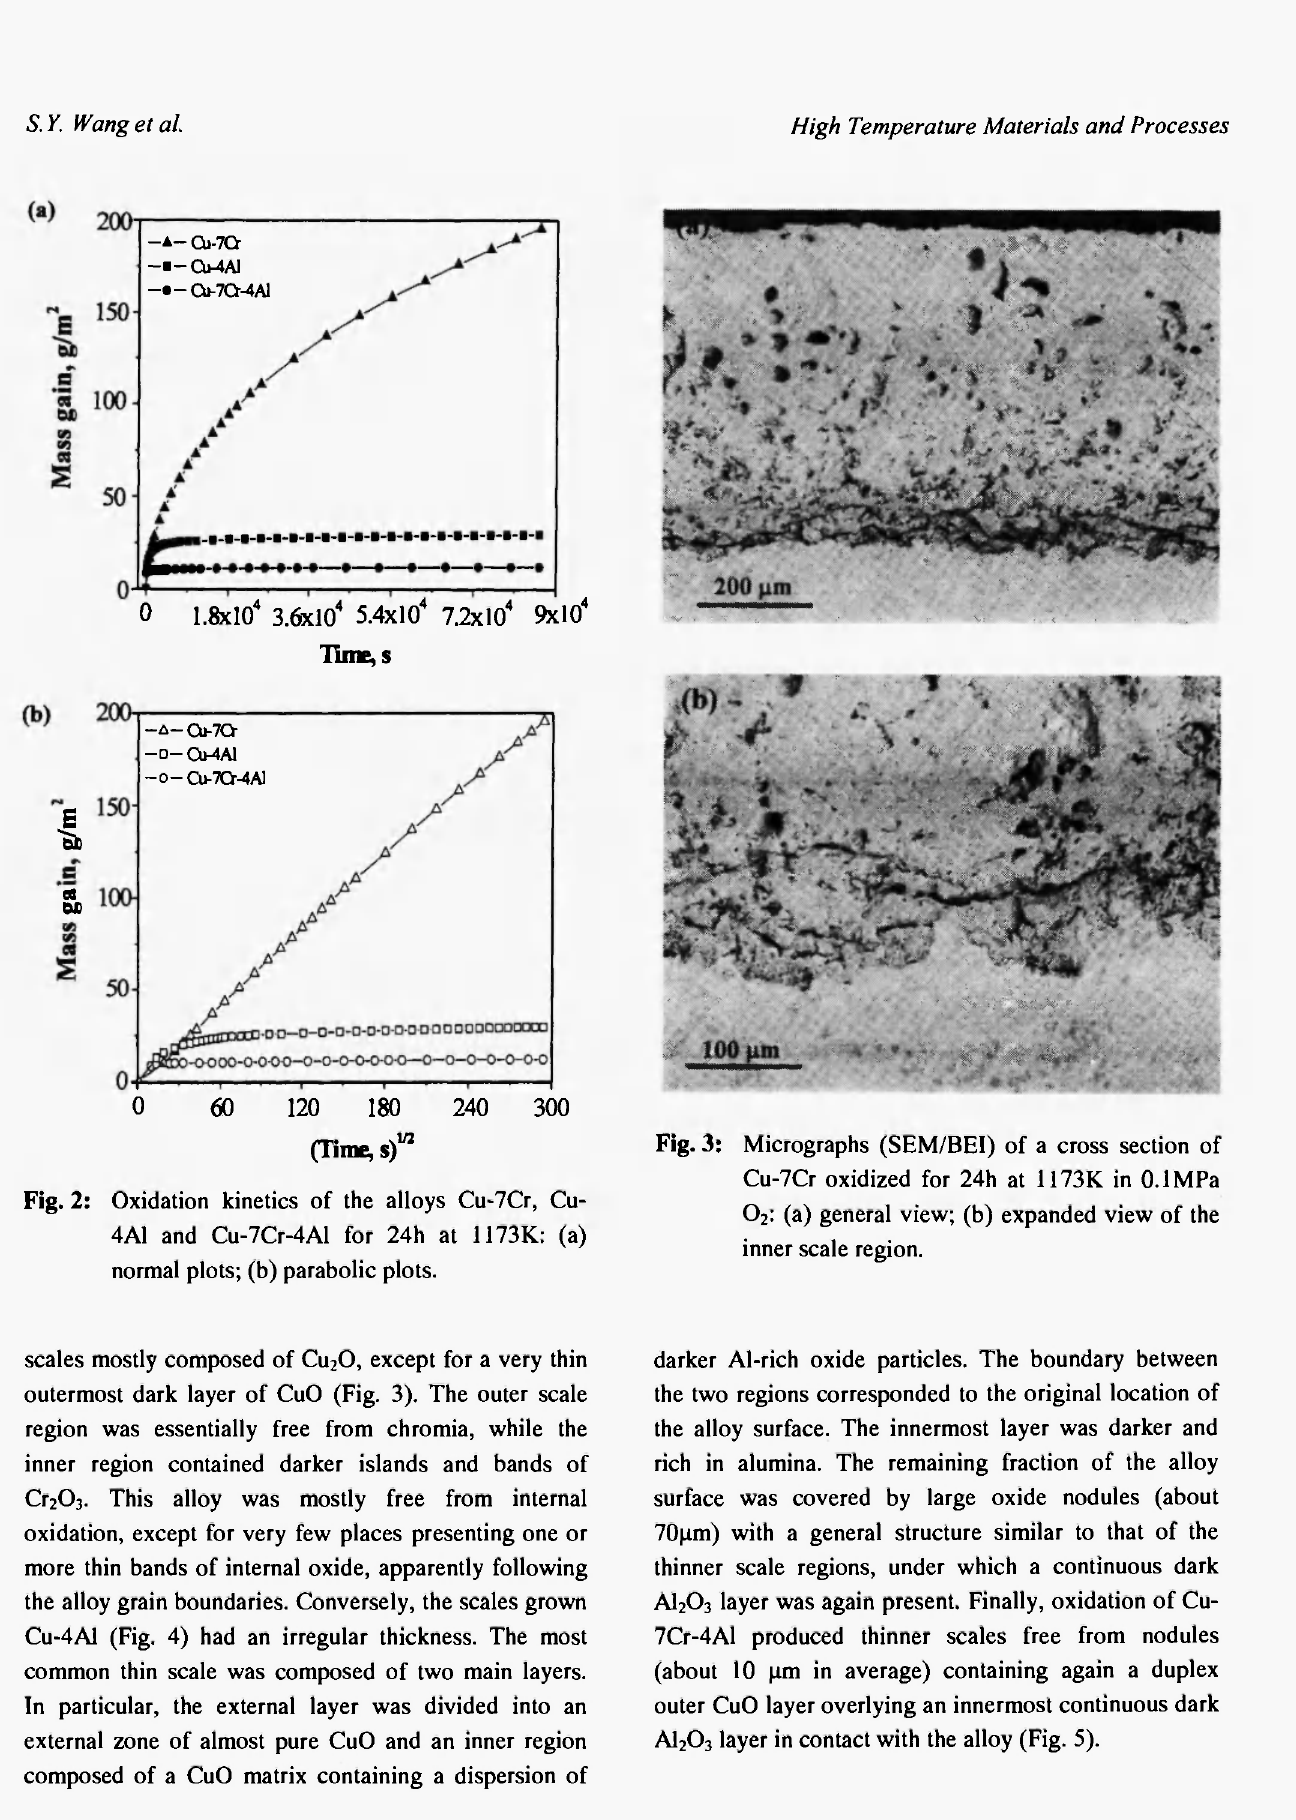
darker Al-rich oxide particles. The boundary between the two regions corresponded to the original location of the alloy surface. The innermost layer was darker and rich in alumina. The remaining fraction of the alloy surface was covered by large oxide nodules (about 70μπι) with a general structure similar to that of the thinner scale regions, under which a continuous dark A1 2 0 3 layer was again present. Finally, oxidation of Cu- 7Cr-4Al produced thinner scales free from nodules (about 10 μπι in average) containing again a duplex outer CuO layer overlying an innermost continuous dark A1 2 0 3 layer in contact with the alloy (Fig.